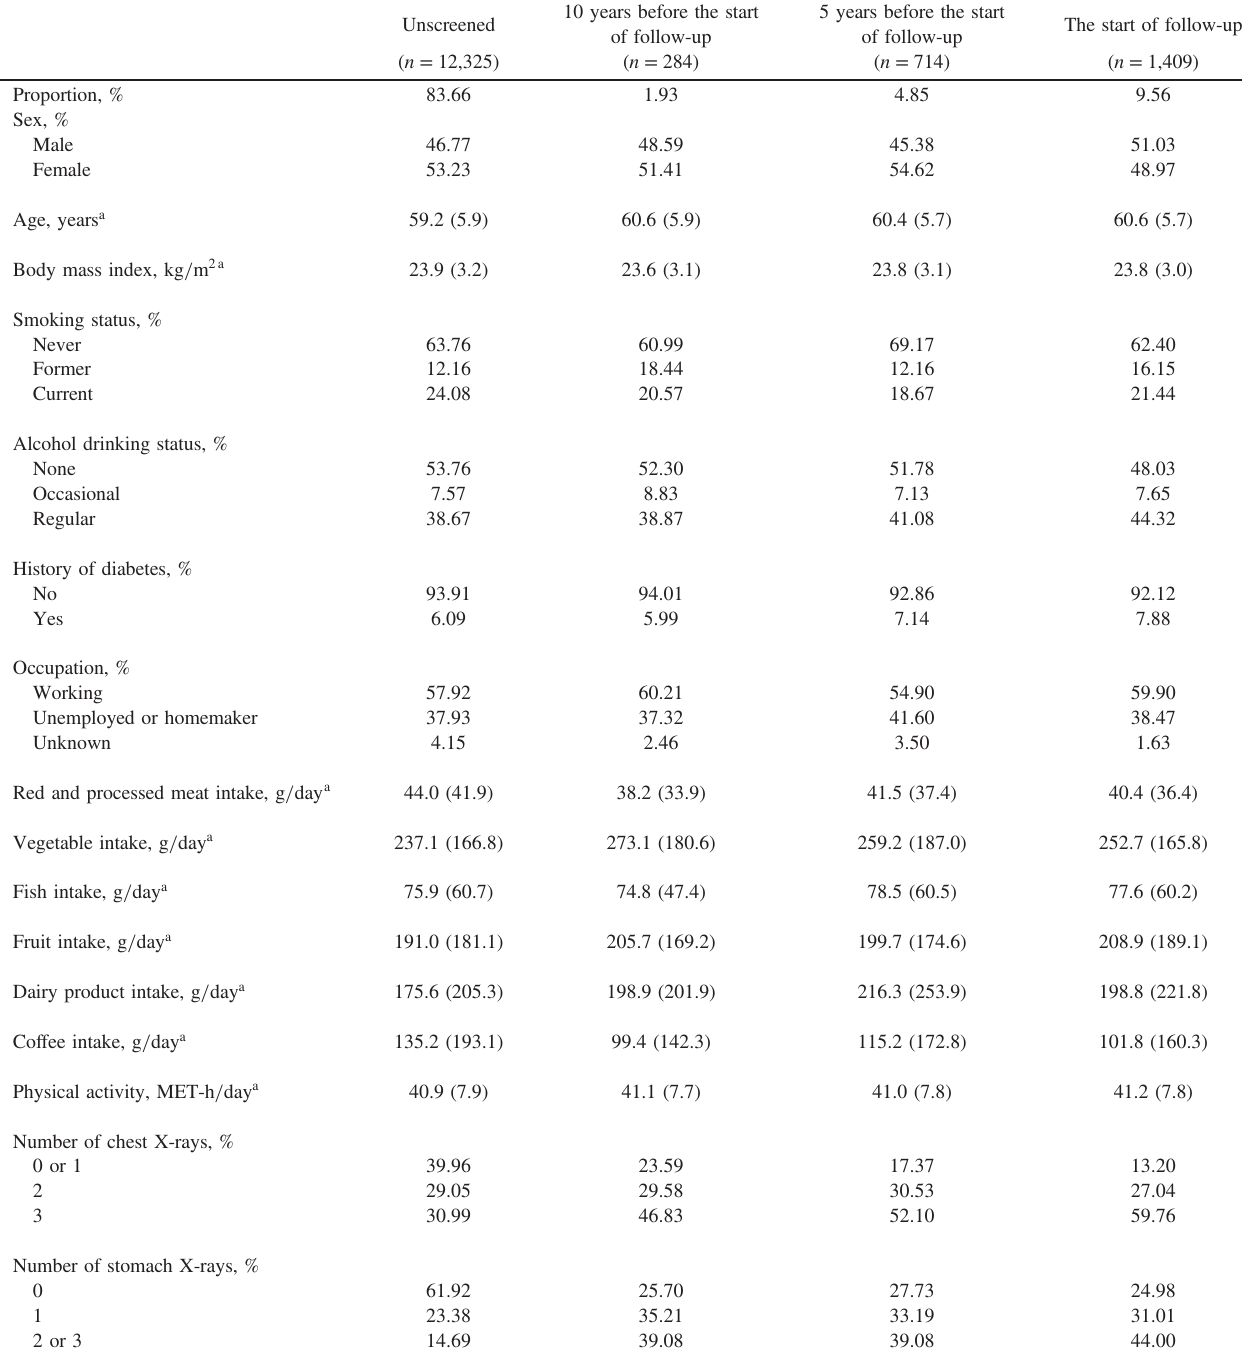
Table 2. Characteristics of study subjects at the start of follow-up according to the latest screening colonoscopy